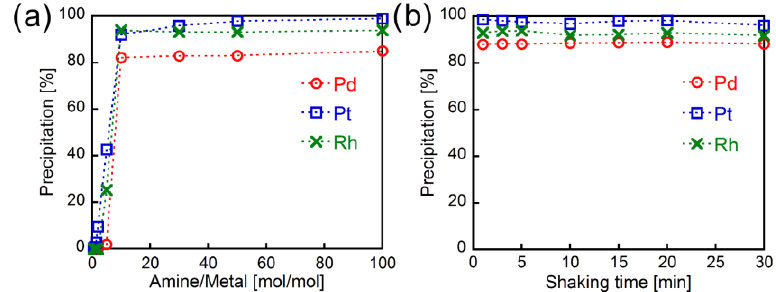
Figure 3. The e ff ect of ( a ) n -nonylamine loading (30 min of shaking) and ( b ) shaking time on the metal precipitation (amine / metal = 50 mol / mol) from 6.0 M HCl solutions containing 1 mM individual metals (Pd(II), Pt(IV), and Rh(III)).